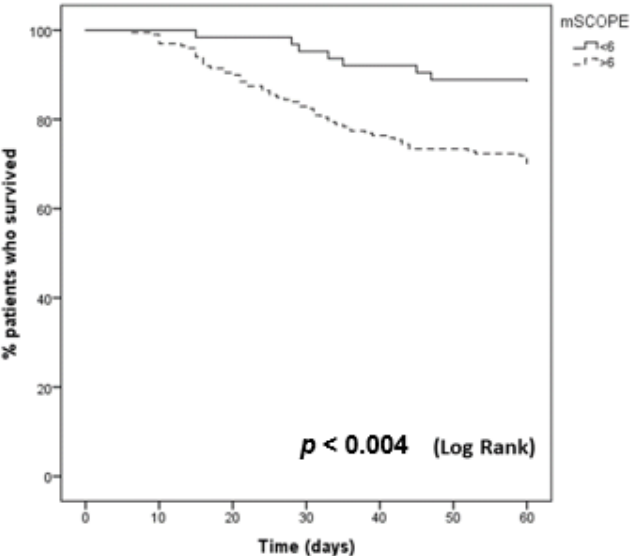
Figure 5. Kaplan-Meier curve comparing patients with mSCOPE ≥ 6 and < on admission, the CCI, and the mSCOPE score (Table 5).